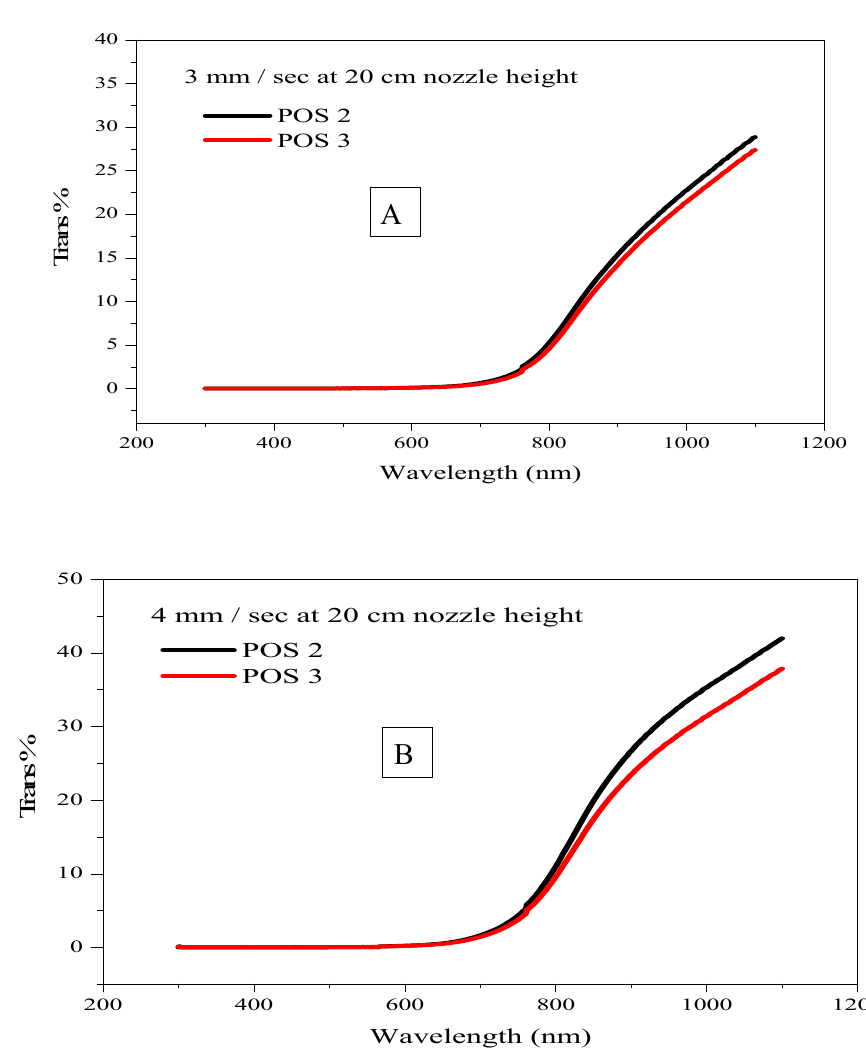
Fig. 2 (A, B): Tramsmitance spectra of CuO at different speed and postions (POS).